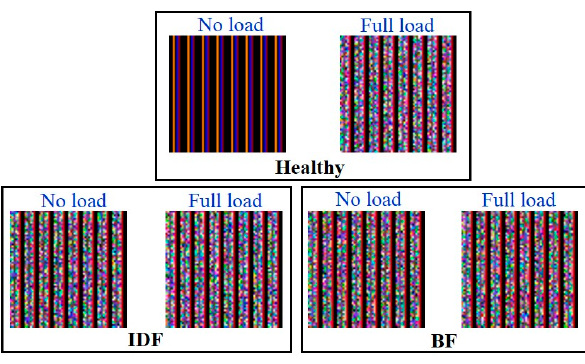
Figure 12. Signal-to-RGB image conversion method.